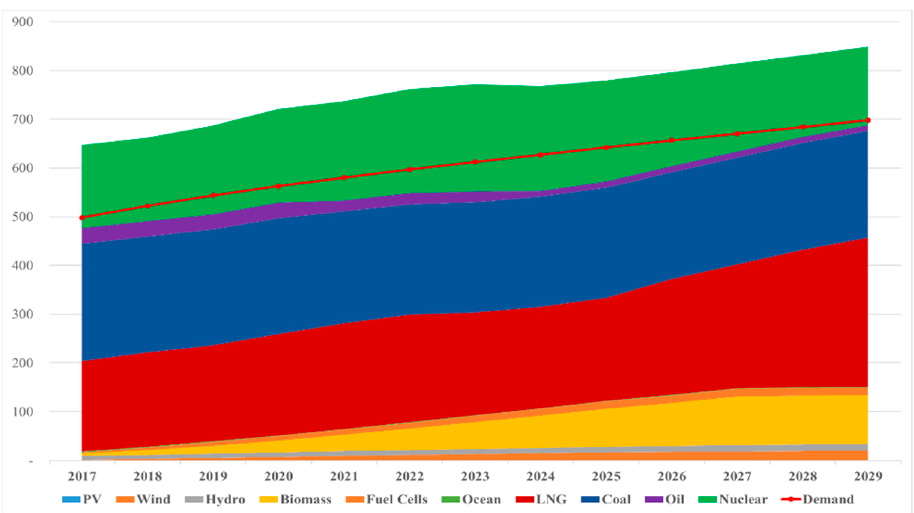
Figure 12. Power generation changes in SC 2 (TWh).